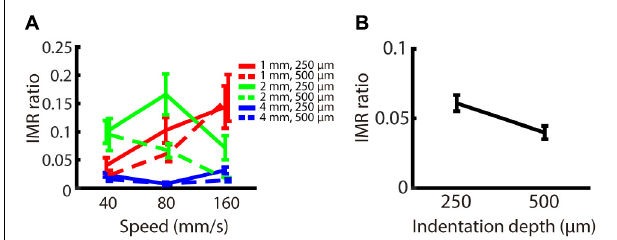
FIGURE 5 | Experiment 2: Effect of indentation depth on IMR. The experimental paradigm was almost identical to Experiment 1, except that we presented speeds only in the middle-speed ranges and indentation depth as 250 or 500 µ m. (A) IMR ratio under spatio-temporal (spatial period; red: 1 mm, green: 2 mm, blue: 4 mm) and indentation depth (solid lines 250 µ m, dashed lines 500 µ m) manipulations. (B) IMR ratio as a function of indentation depth showed that IMR ratio did not significantly depend on indentation depth (null hypothesis test F ( 1 , 162 ) = 1.855, p = 0.175). The equivalence test also confirmed that there was no significant difference in the IMR ratio between indentation depths (Welch two sampled TOST equivalence test, boundaries = ± 0.1886, DF = 143.14, p < 0.001). Bars indicate standard error of the mean.